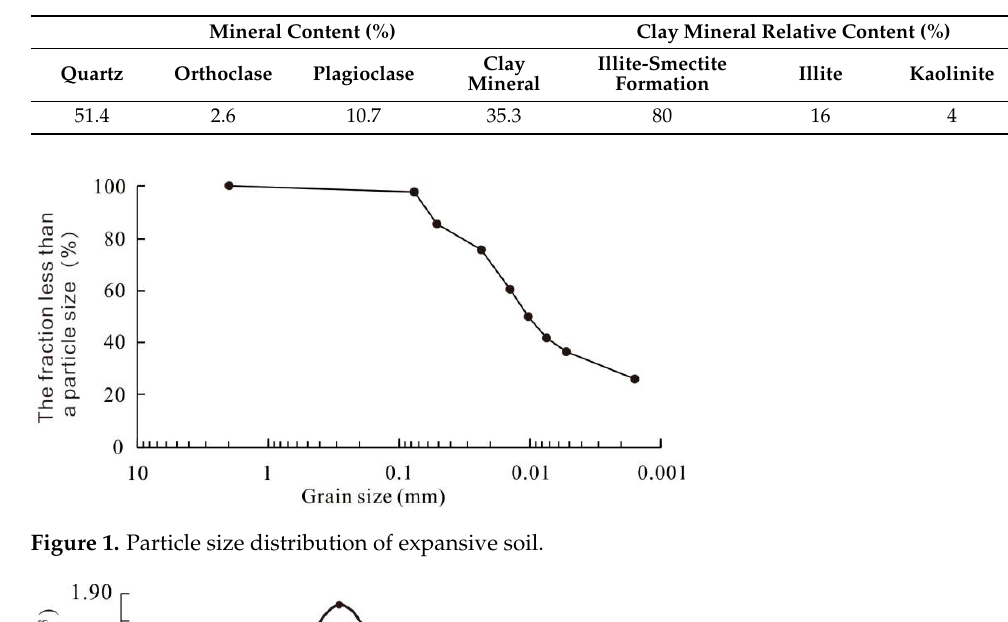
Table 2. Mineral composition of expansive soil.